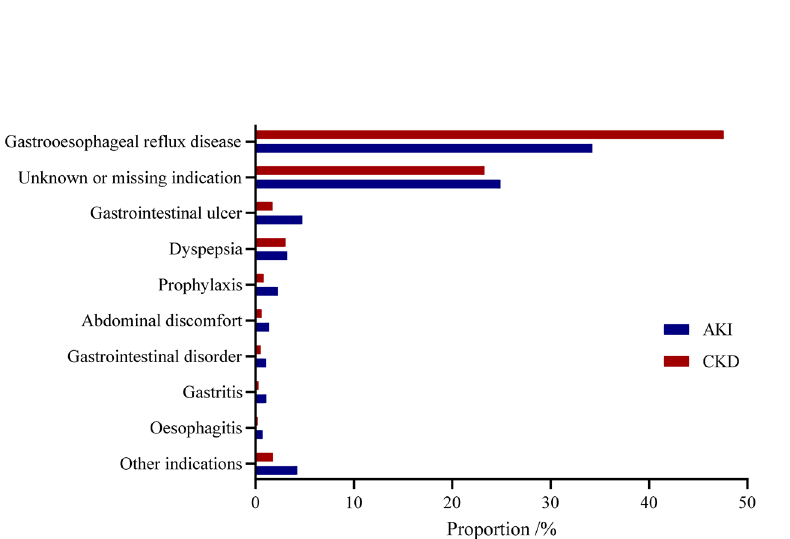
Figure 2. Indications of PPIs associated AKI and CKD cases from FAERS database. PPIs proton pump inhibitors, AKI acute kidney injury, CKD chronic kidney